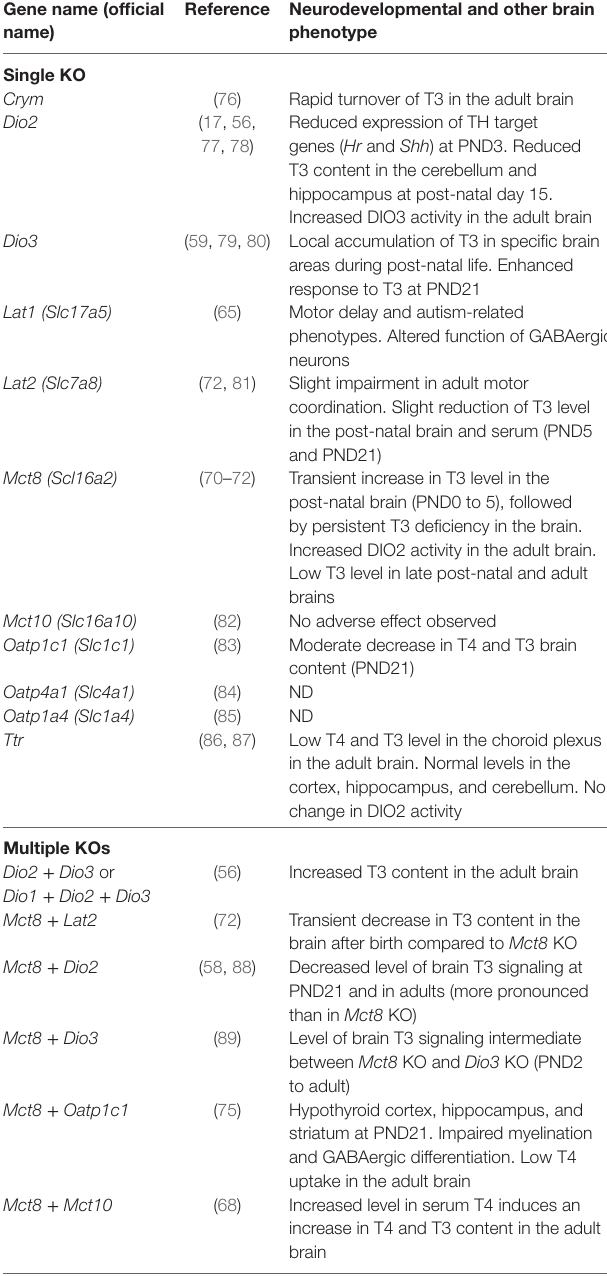
Gene name (official